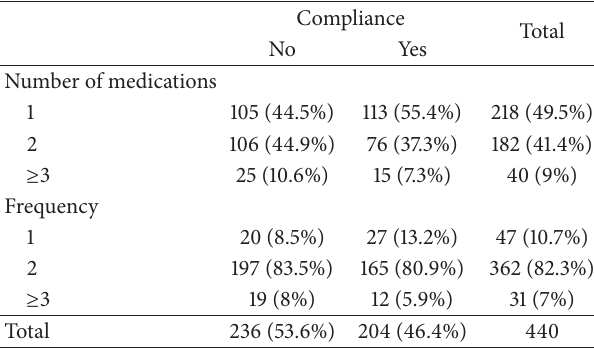
Table6:Multivariatelogisticregressionanalysisoffactorsevaluated for association with noncompliance to antiglaucoma